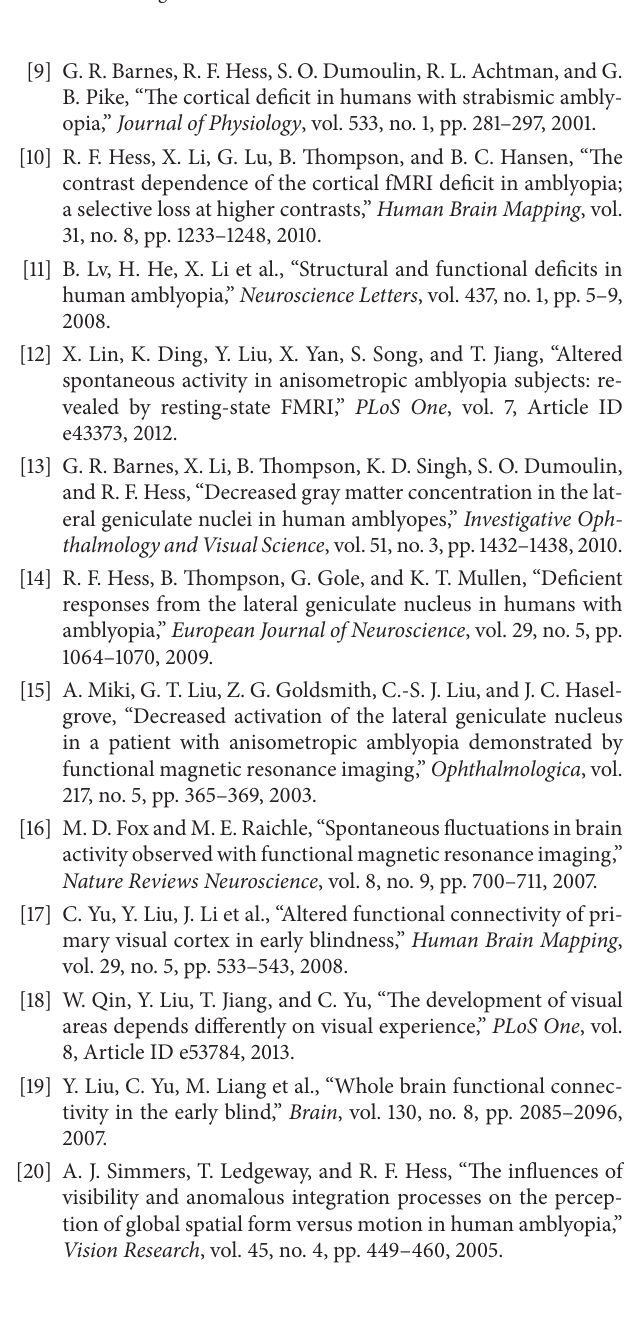
= 0.01 ). alpha 5.28 4.26 − 52 − 36 − 18 3.99 3.46 − 62 − 44 − 18 − 4.52 − 3.81 − 18 − 60 − 52 − 3.17 − 2.87 − 30 − 58 − 50 − 3.69 − 3.25 − 26 − 74 − 32 3.37 − 3.02 − 16 − 68 −